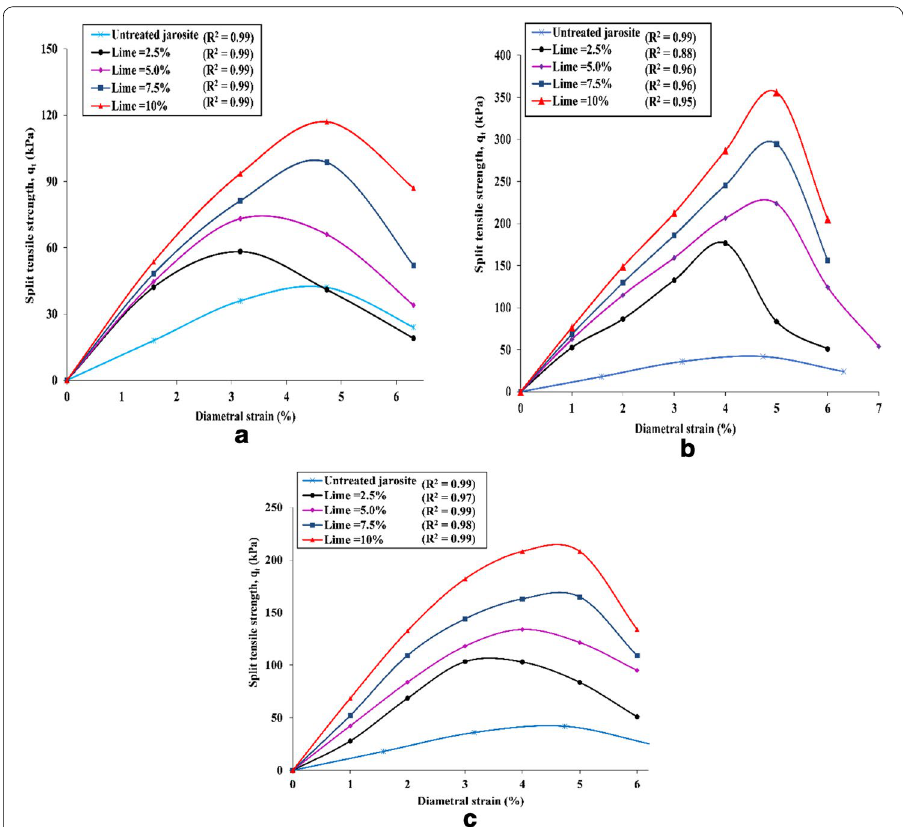
Fig. 5 Effect of lime content on Stress–Strain behaviour of split tensile samples cured at a 7, b 28, and c 90 days